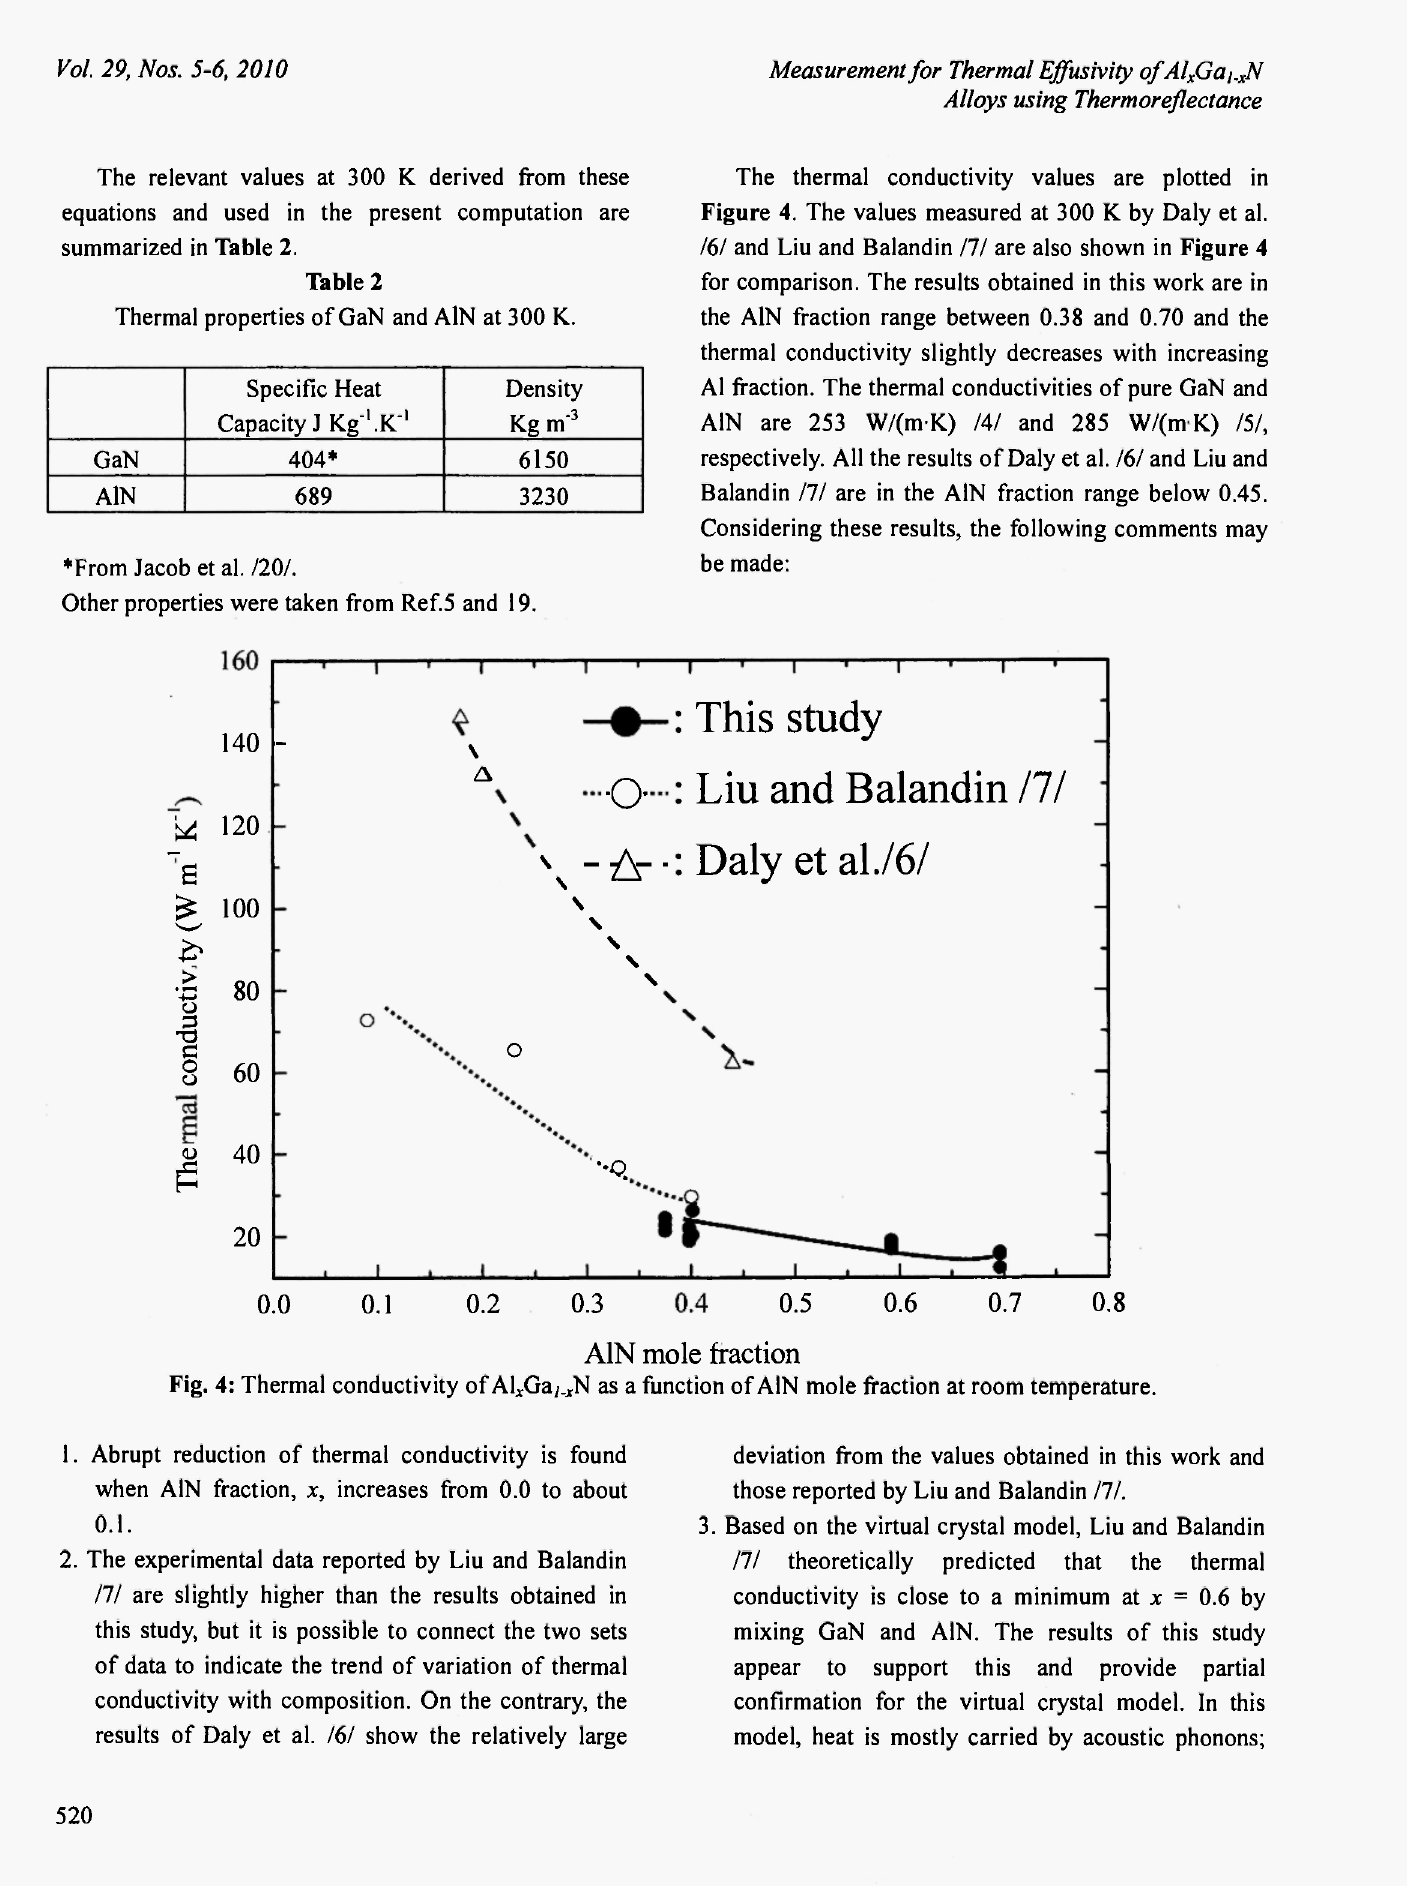
Fig. 4: Thermal conductivity of Al x Ga/. x N as a function of A1N mole fraction at room temperature. 1. Abrupt reduction of thermal conductivity is found when A1N fraction, x, increases from 0.0 to about 0